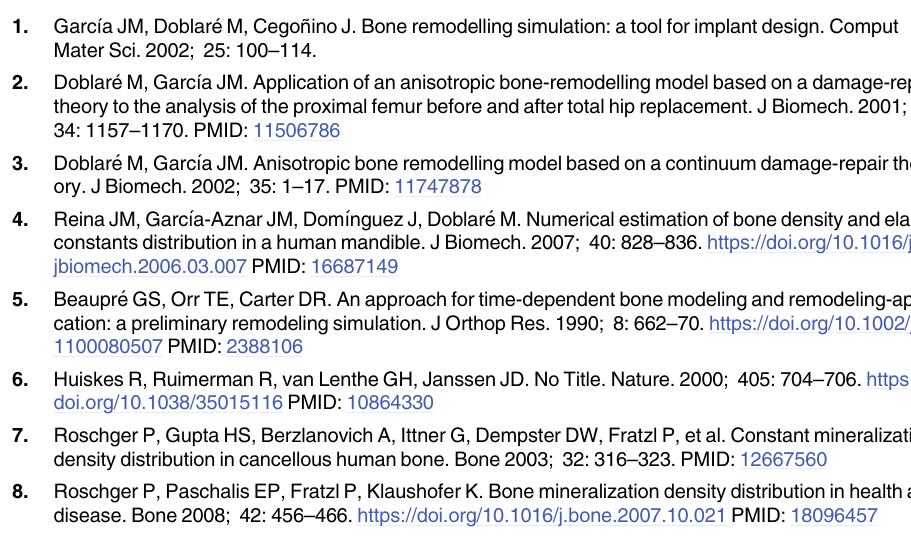
S1 Table. Values of the parameter of the model presented in supporting